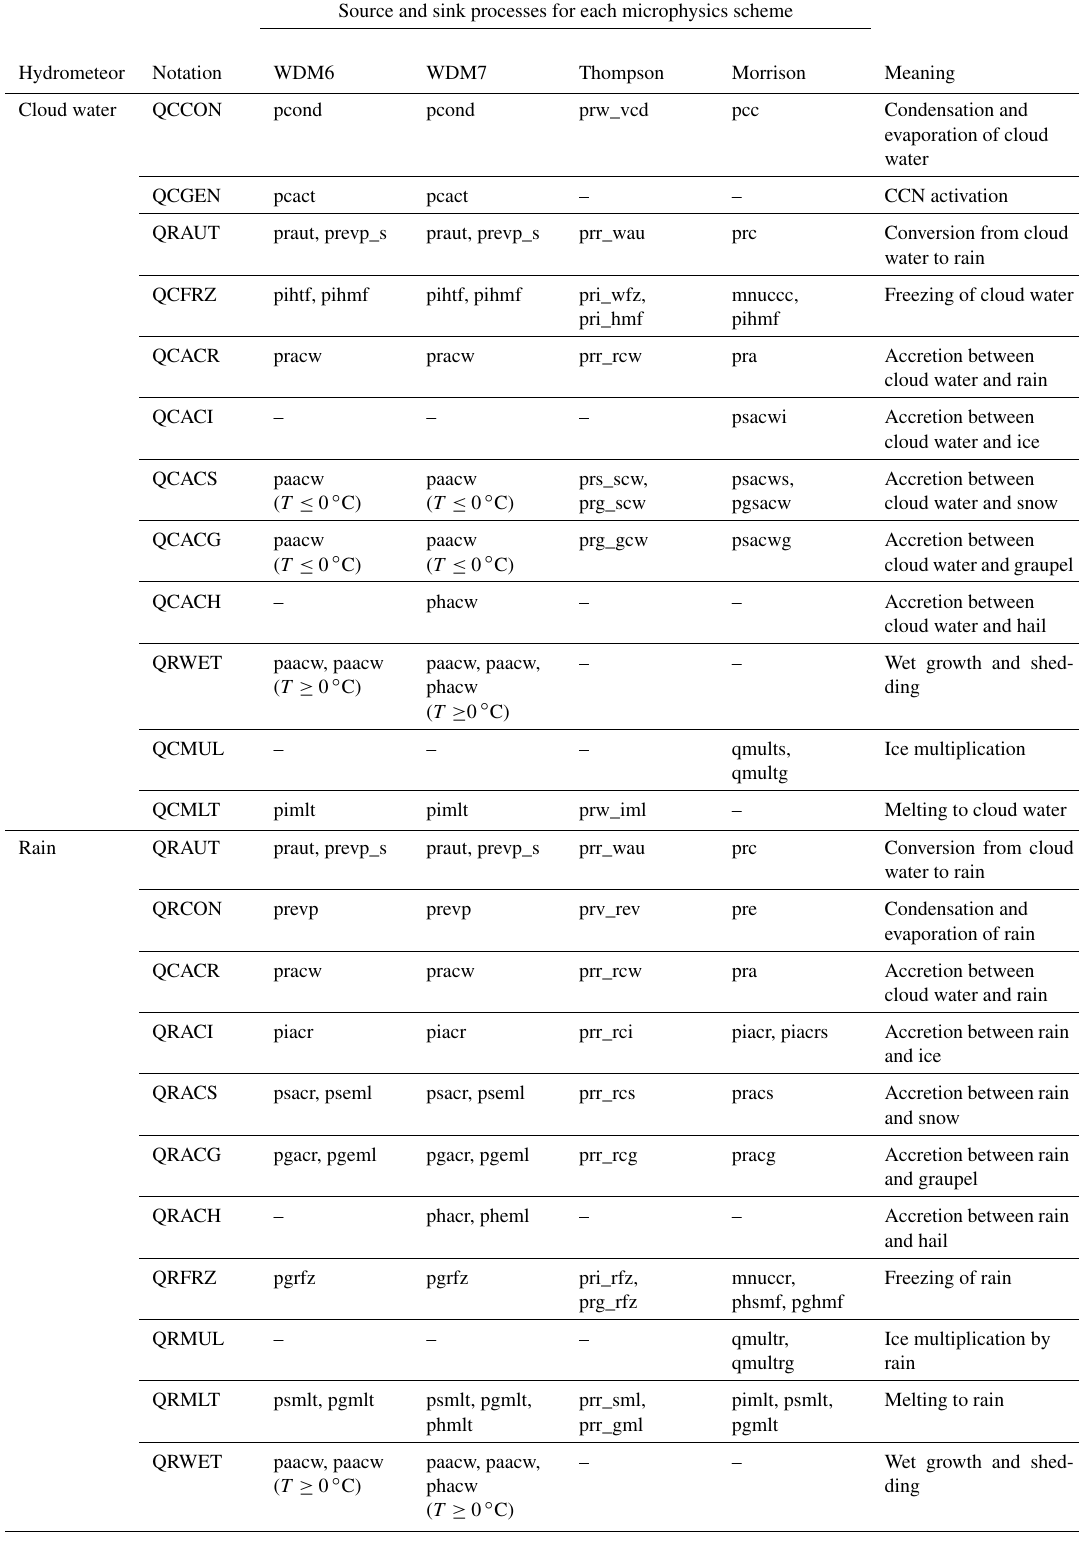
Table 4. List of symbols for cloud microphysical processes in each microphysics scheme and their meaning. Differently named microphysical processes in each scheme are coordinated in our study using the names addressed in the “notation”